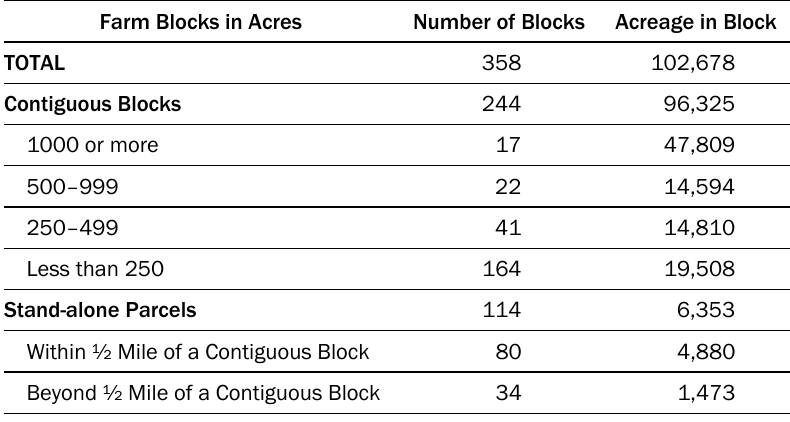
Table 3. Contiguous and Stand Alone Farms by Acreage,